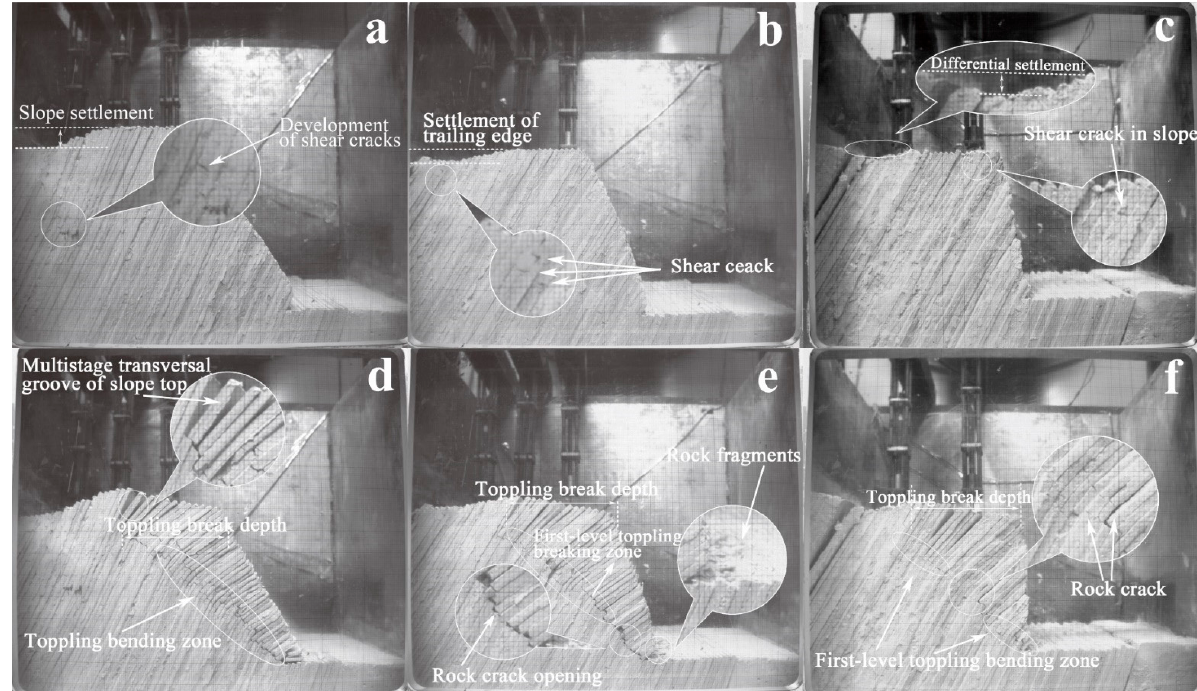
Figure 6. The deformation of the slopes, ( a ) the deformation signs of the 55 ◦ slopes in the initial stage, ( b ) the deformation signs of the 65 ◦ slopes in the initial stage, ( c ) the deformation signs of the 75 ◦ slopes in the initial stage, ( d ) the deformation signs of the 55 ◦ slopes, ( e ) the deformation signs of the 65 ◦ slopes, ( f ) the deformation signs of the 75 ◦